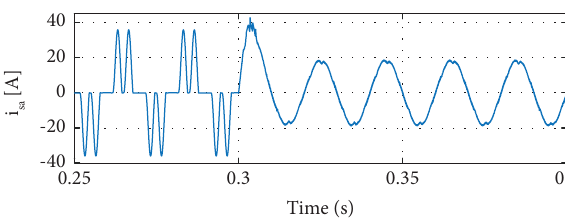
Figure 10: Experimental results for APF using SC under RLC load.